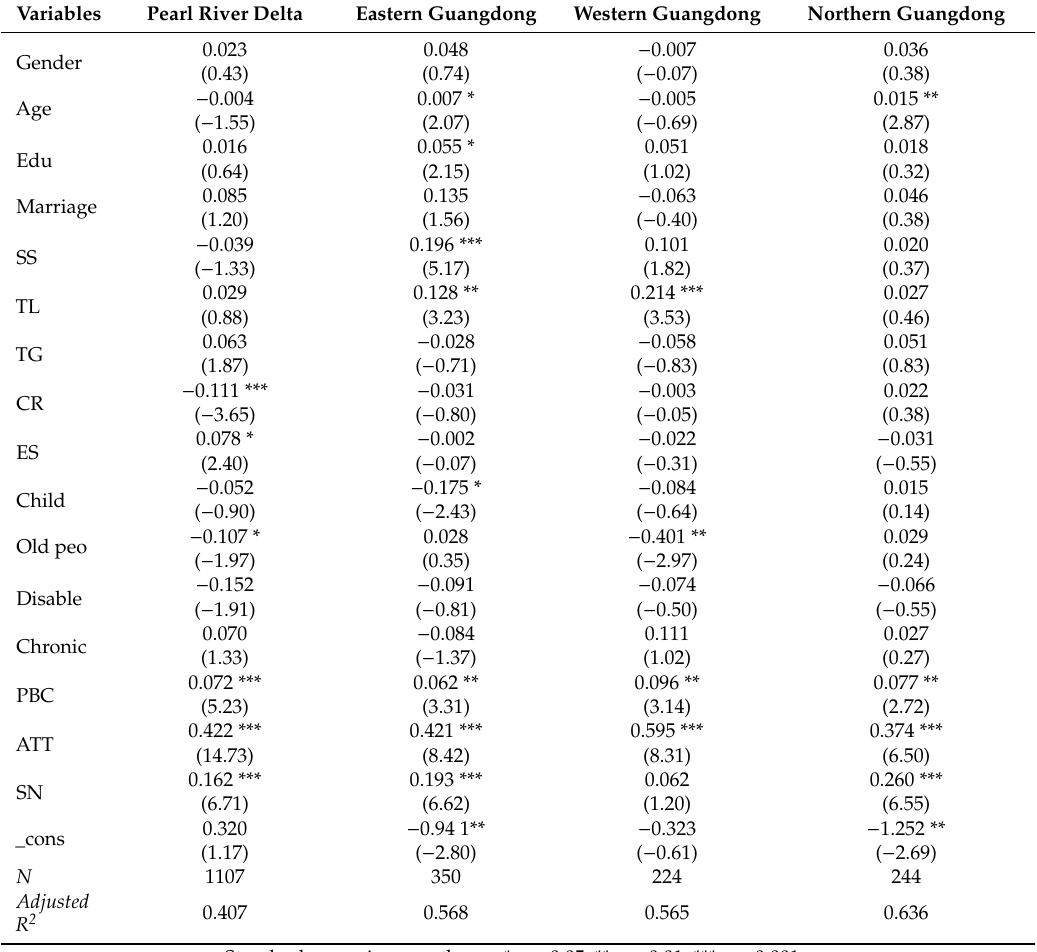
Table 5. Regression on SI in the Pearl River Delta and Eastern, Western, and Northern Guangdong.